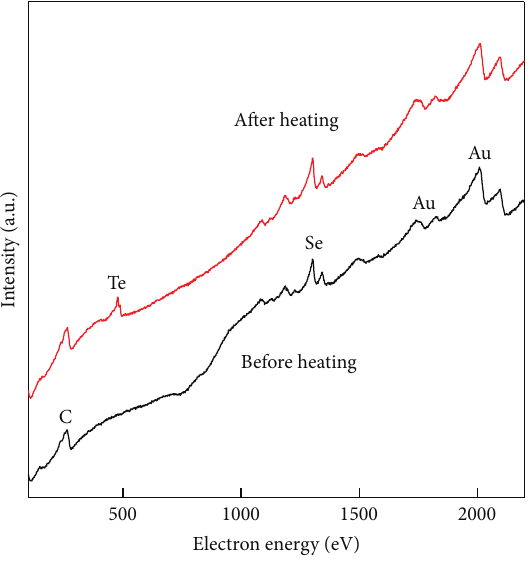
Figure 6: AES spectra of electrodeposited Te/Se stacked layers before and after annealing.